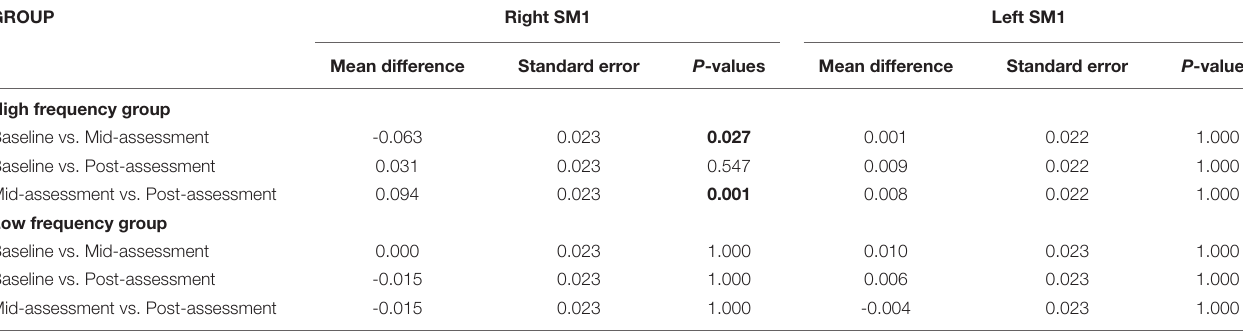
TABLE 4 | The beta values of SM1 in the Bonferroni correction for multiple comparisons within high frequency group and low frequency group, respectively. GROUP Right SM1 Left SM1 Mean difference Standard error P -values Mean difference Standard error P